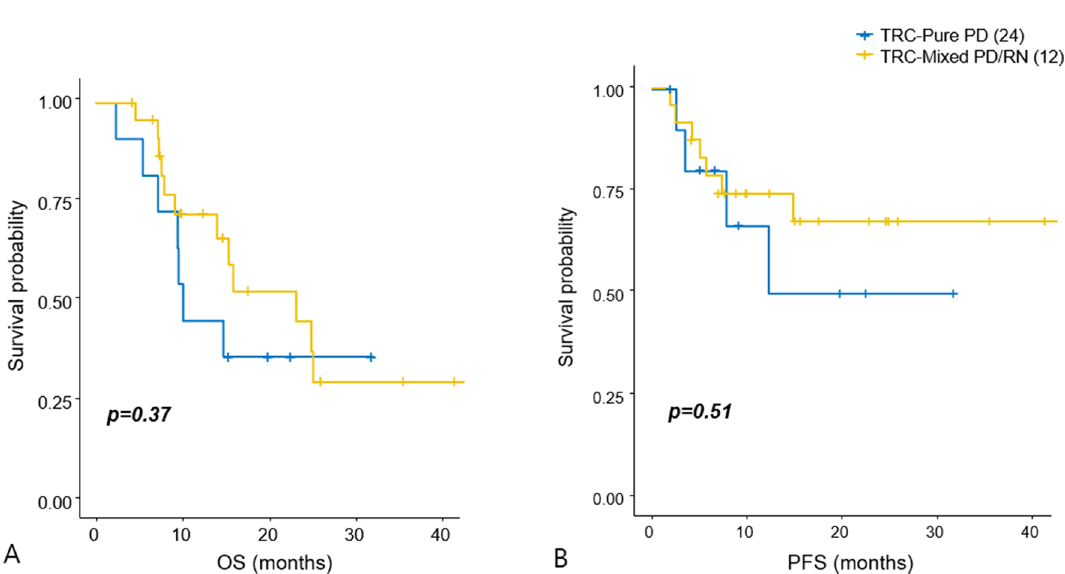
Figure 4. Subgroup analysis of patients with TRC-PD. Comparison of the KM curve of OS and PFS between TRC-PD patients with pure metastatic tumor cells (n = 24, A ) and mixed pathology of radiation necrosis and progressive tumor (n = 11, B ), respectively. OS overall survival, PD progressive disease; PFS progression-free survival, RN radiation necrosis, TRC treatment-related